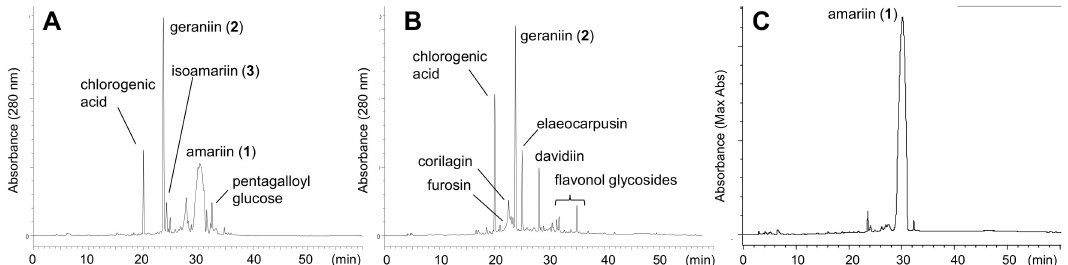
Figure 3. HPLC profiles of extracts of Carpinus laxiflora fresh leaves collected in April ( A ) and collected in October ( B ), and amariin ( 1 ) isolated from the April leaves ( C ).